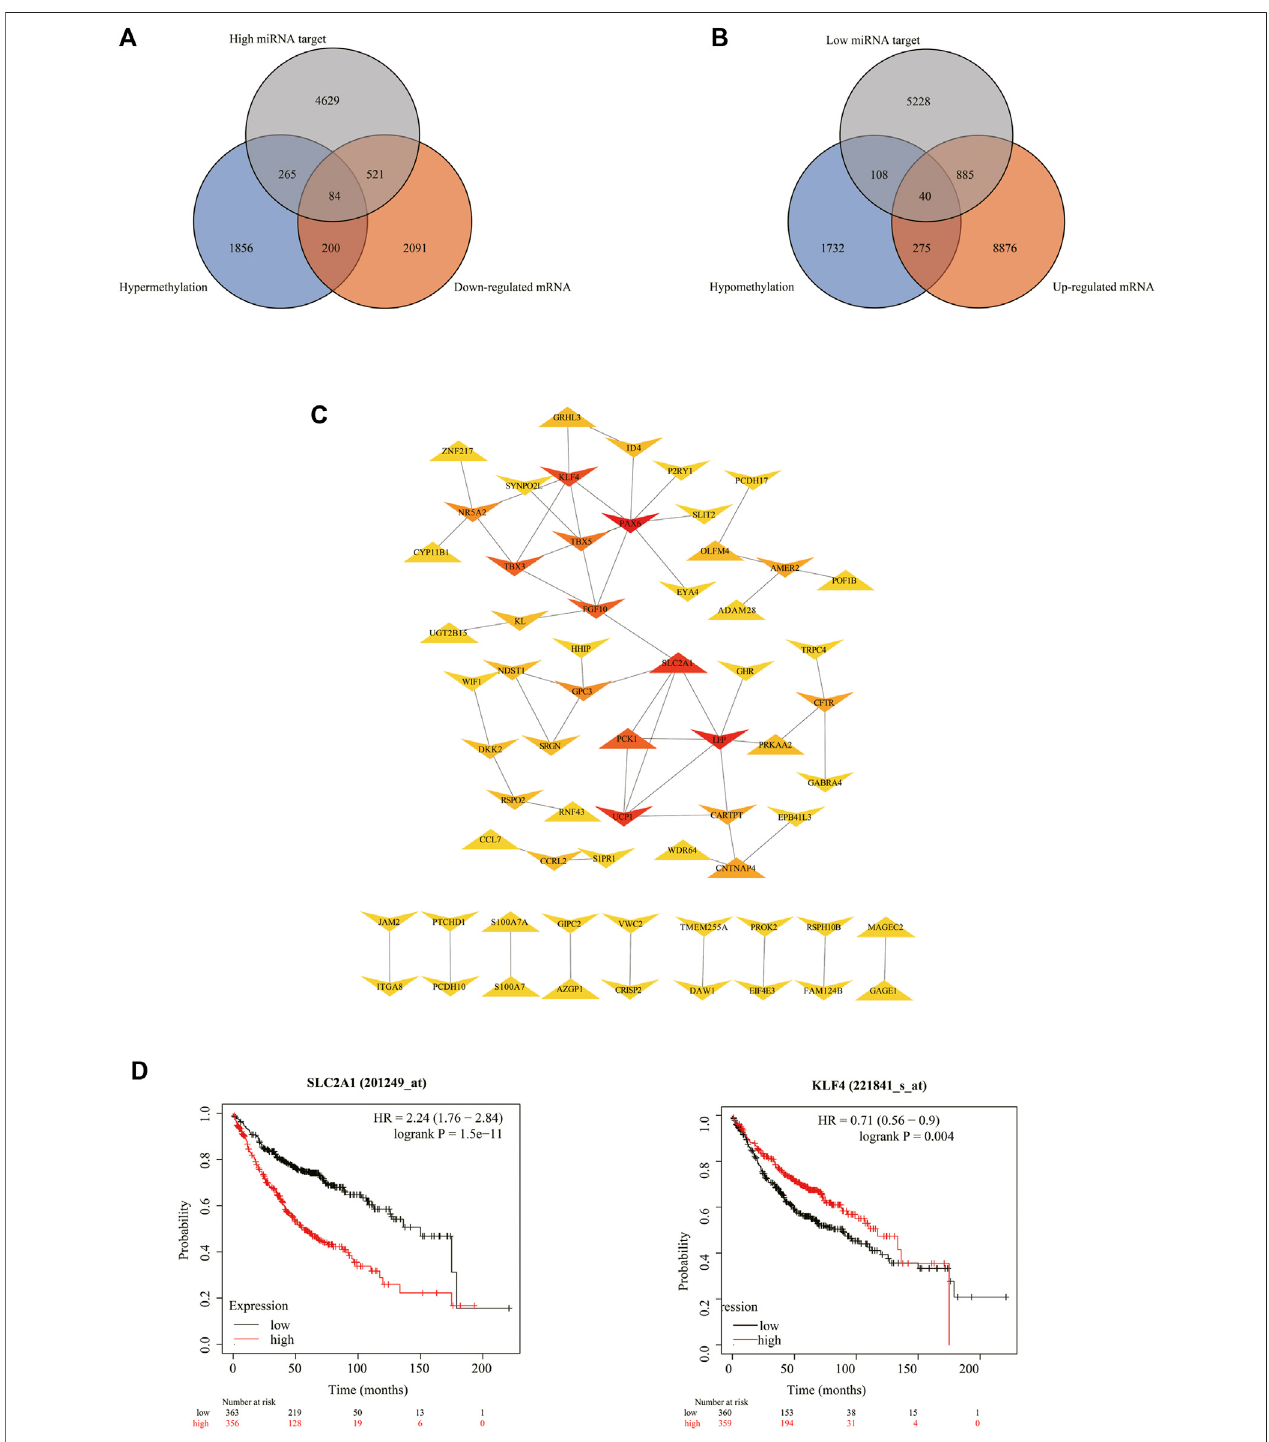
FIGURE 6 | Details for all the overlapped genes. (A,B) Venn graph for all the overlapped genes including 84 downregulated genes and 40 upregulated genes, respectively. (C) PPI network of all the overlapped genes including 84 downregulated genes and 40 upregulated genes. (D) Kaplan – Meier analysis of patients with low (black curve) and high (red curve) expressions of SLC2A1 and KLF4 .